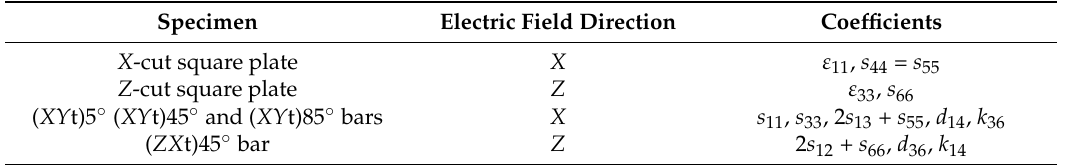
Table 1. Effective elastic and piezoelectric constants for different